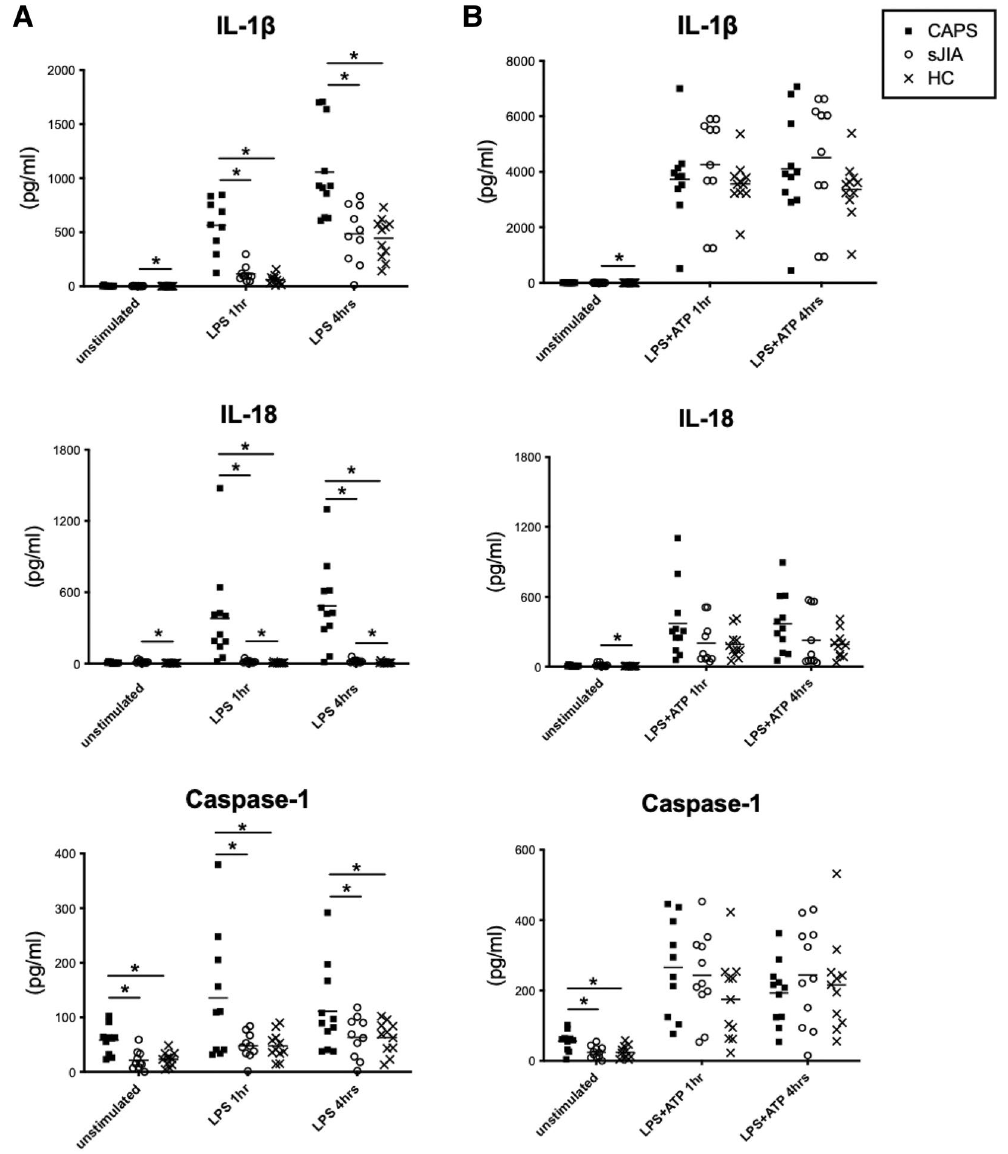
Figure 2. Secretion of inflammatory cytokines upon in vitro stimulation test. Secretion of IL-1β, IL-18 and caspase-1 differentiates between patients with CAPS, sJIA and healthy controls. IL-1β, IL-18 and caspase-1 secretion were measured in the supernatant of PBMCs isolated from patients with CAPS, sJIA and control donors with medium only and 1 and 4 h after A) LPS stimulation, and B) LPS-primed ATP stimulation regimen. Data are shown as dot plat with means. * indicates p < 0.05. Abbreviations: CAPS- cryopyrin-associated periodic syndrome; sJIA-systemic juvenile idiopathic arthritis; HC- healthy controls; IL-1β- interleukin 1β; IL-18- interleukin 18; LPS- lipopolysaccharide; ATP- adenosine triphosphate; PBMC- peripheral blood mononuclear alone, LPS and LPS-primed ATP regimen. Shown in Fig. 2A, significant increase in the levels of IL-1β, IL-18 and caspase 1 were detected in the soup of PBMCs isolated from patients with CAPS at 1 h and 4 h upon LPS stimuli in comparison to those isolated from sJIA and healthy controls (all p < 0.05). While higher levels of IL-18 were produced by sJIA PBMCs consistently regardless of LPS stimuli when compared to those healthy controls ( p = 0.01, 0.03, 0.05, without and 1 and 4 h of stimulation, respectively), the production of IL-1β and caspase-1 did not significantly increase in sJIA PBMCs as compared to healthy controls upon LPS stimulation (all p > 0.05). Interestingly, caspase-1 production is increased in the CAPS PBMCs when compared to those isolated from sJIA and healthy controls before additional stimulants were applied (all p < 0.05). Moreover, the levels of IL-1β were also slightly higher in the sJIA PBMCs as compared to the healthy controls before stimulation ( p = 0.03). Extracellular ATP is a potent activator for NLRP3 inflammasome 26 . When PBMCs were provided with addi- tional ATPs followed by LPS priming, the levels of caspase 1 and IL-1β increased by 2 to 4 folds universally, as